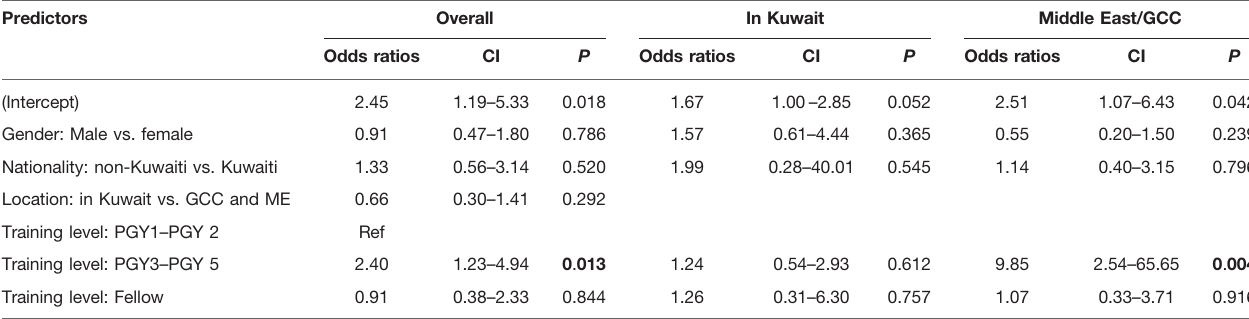
Analysis was performed using binary logistic regression.